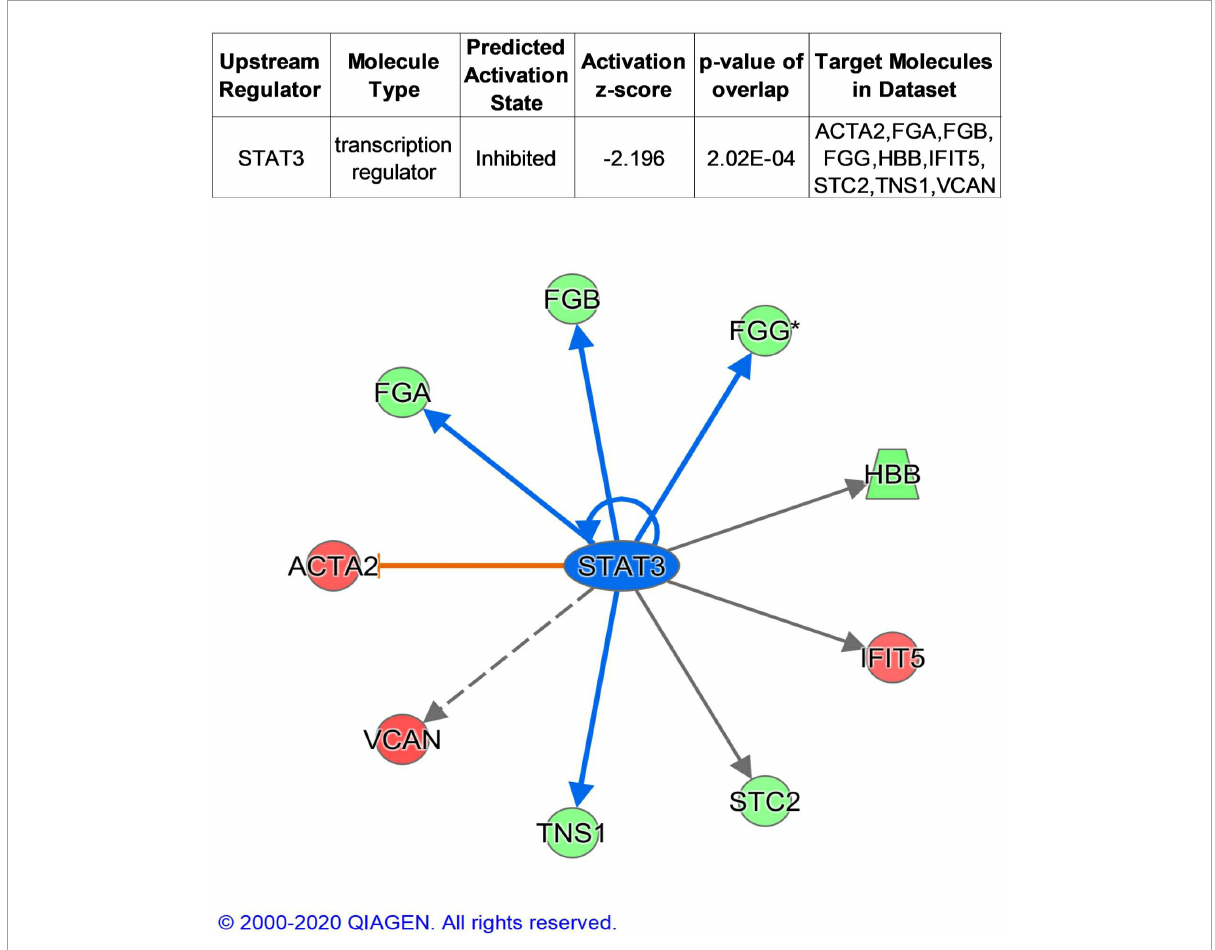
FIGURE5 Upstream analysis of DEPs. Colorized nodes represented our input proteins. Green, down-regulated proteins. Red, up-regulated